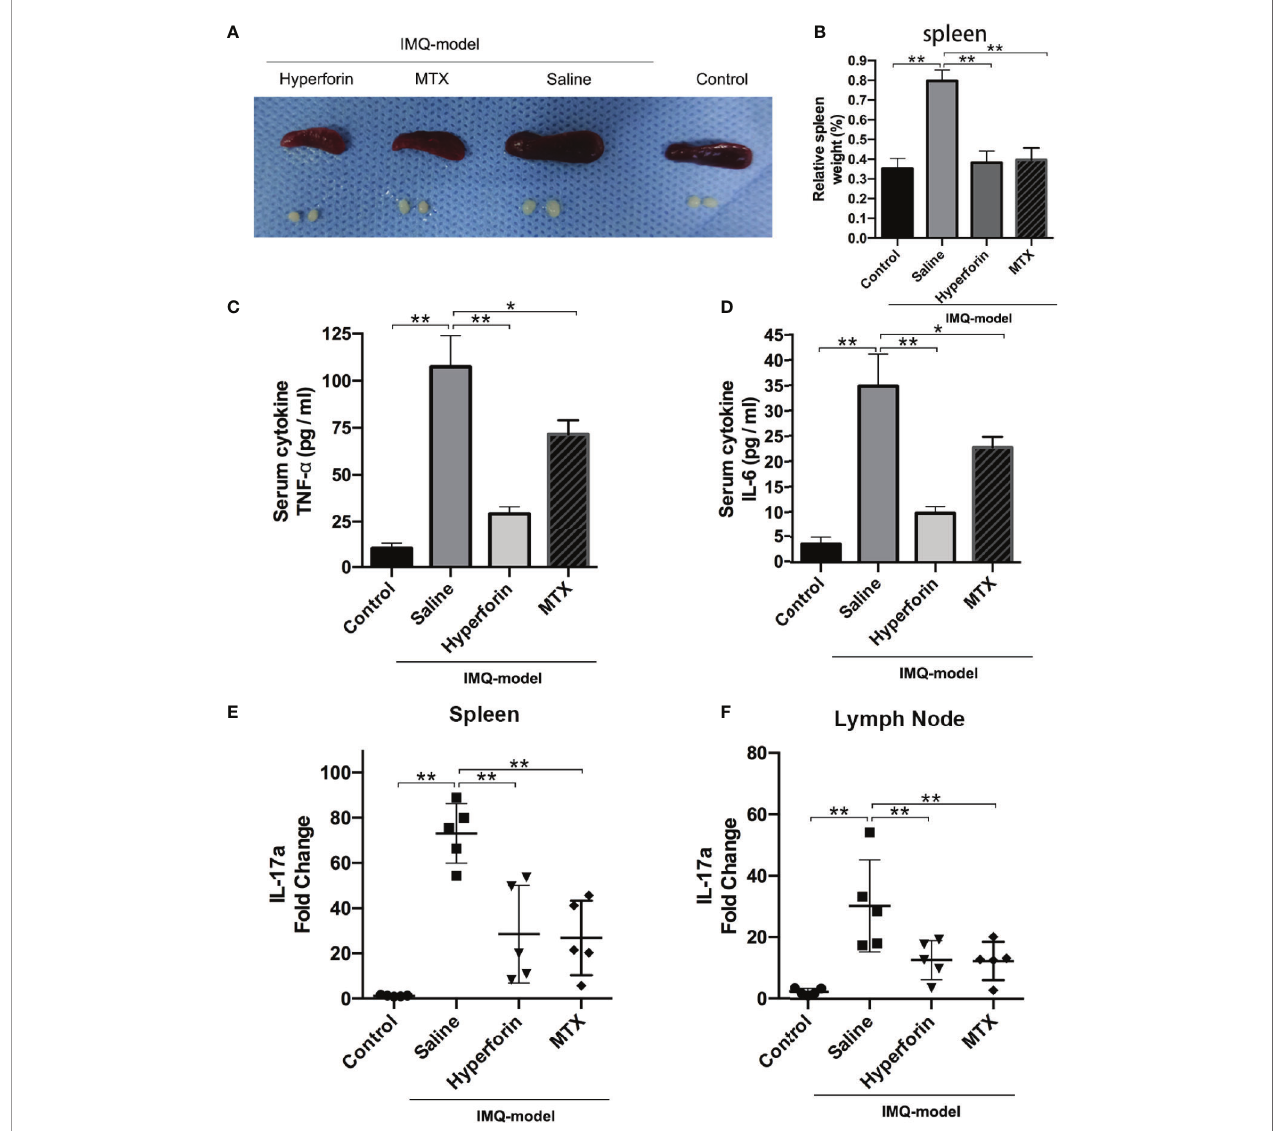
FIGURE 3 | Hyperforin suppressed imiquimod-induced systemic in fl ammation (A) The photos of spleen and skin draining lymph nodes taken at 7th day after IMQ painting. (B) Relative spleen weight of the control and test groups. (C, D) Serum levels of TNF- a and IL-6. (E, F) The mRNA levels of Il17a in spleen and axillary lymph nodes. (n = 5 mice). *P < 0.05 and **P < 0.01 vs model